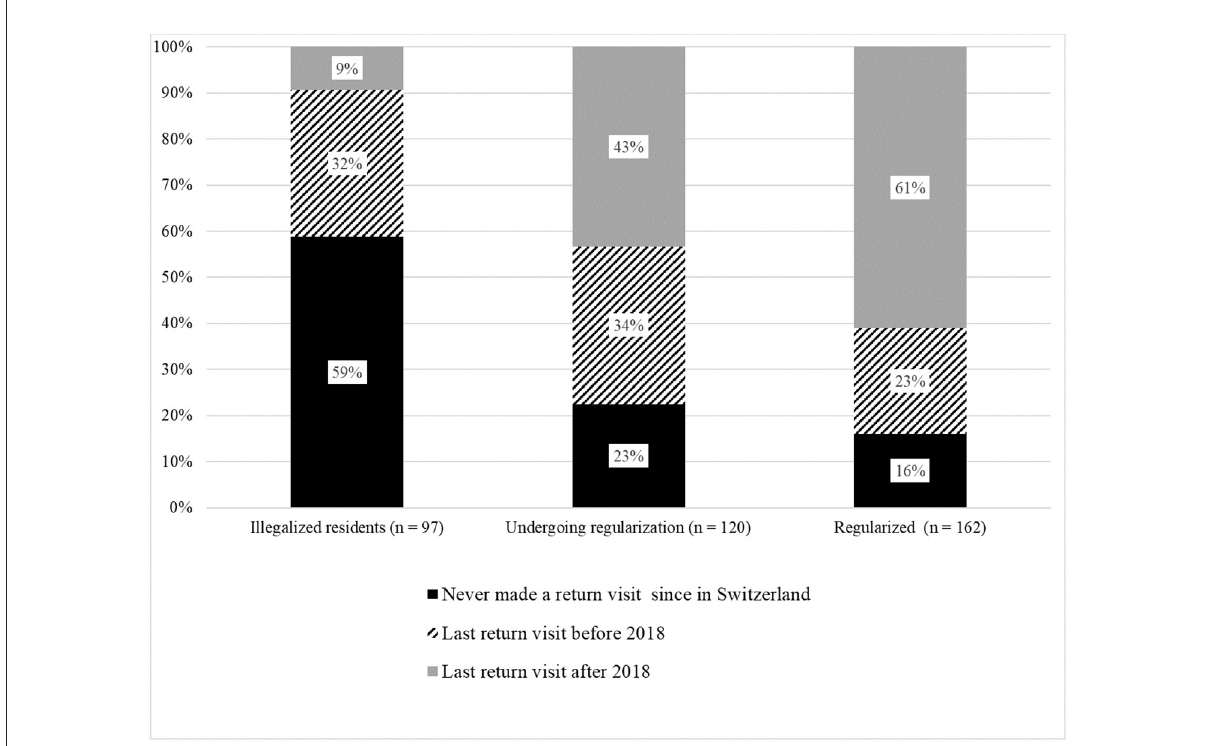
FIGURE2 Return visits by stages of the regularization process in